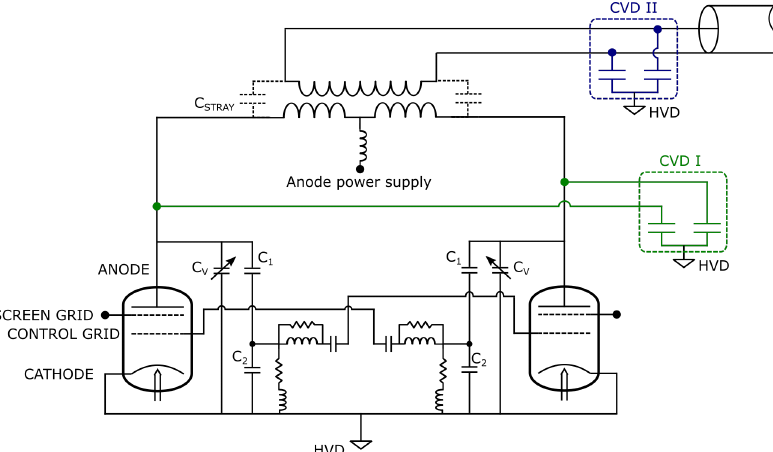
Figure 2. Detail of ISRF unit. The original CVD configuration (CVD II) and the modified one (CVD I) are both represented.